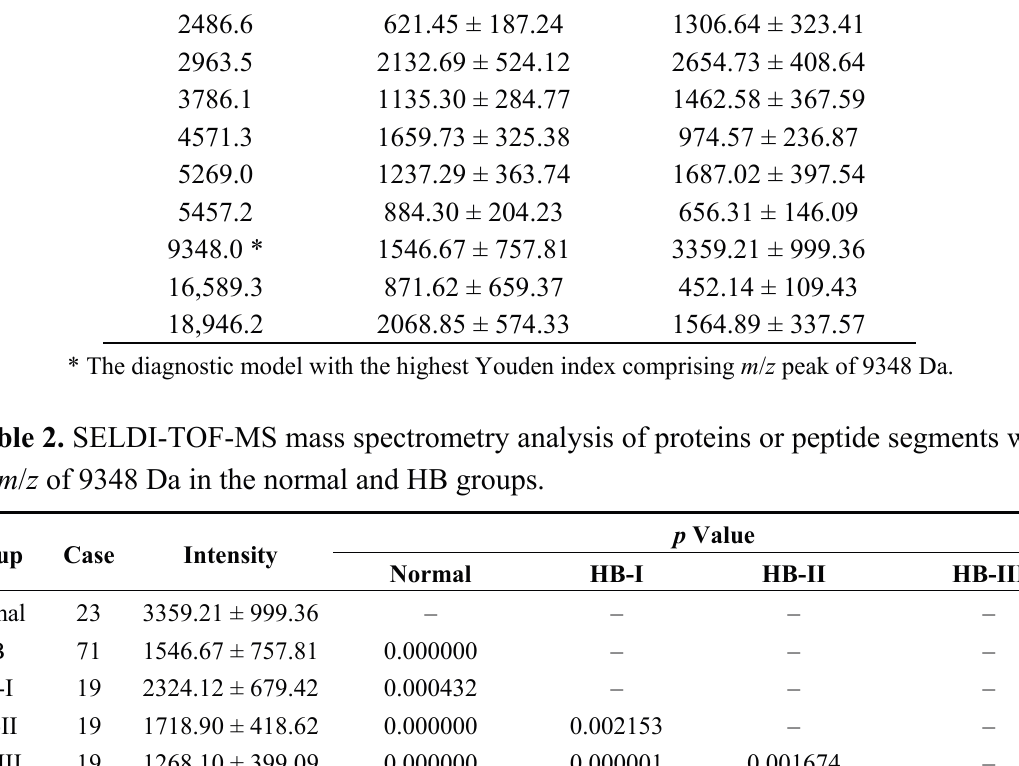
Table 1. The ten differentially expressed proteins in hepatoblastoma vs. normal (mean ± SD). m / z (Da)